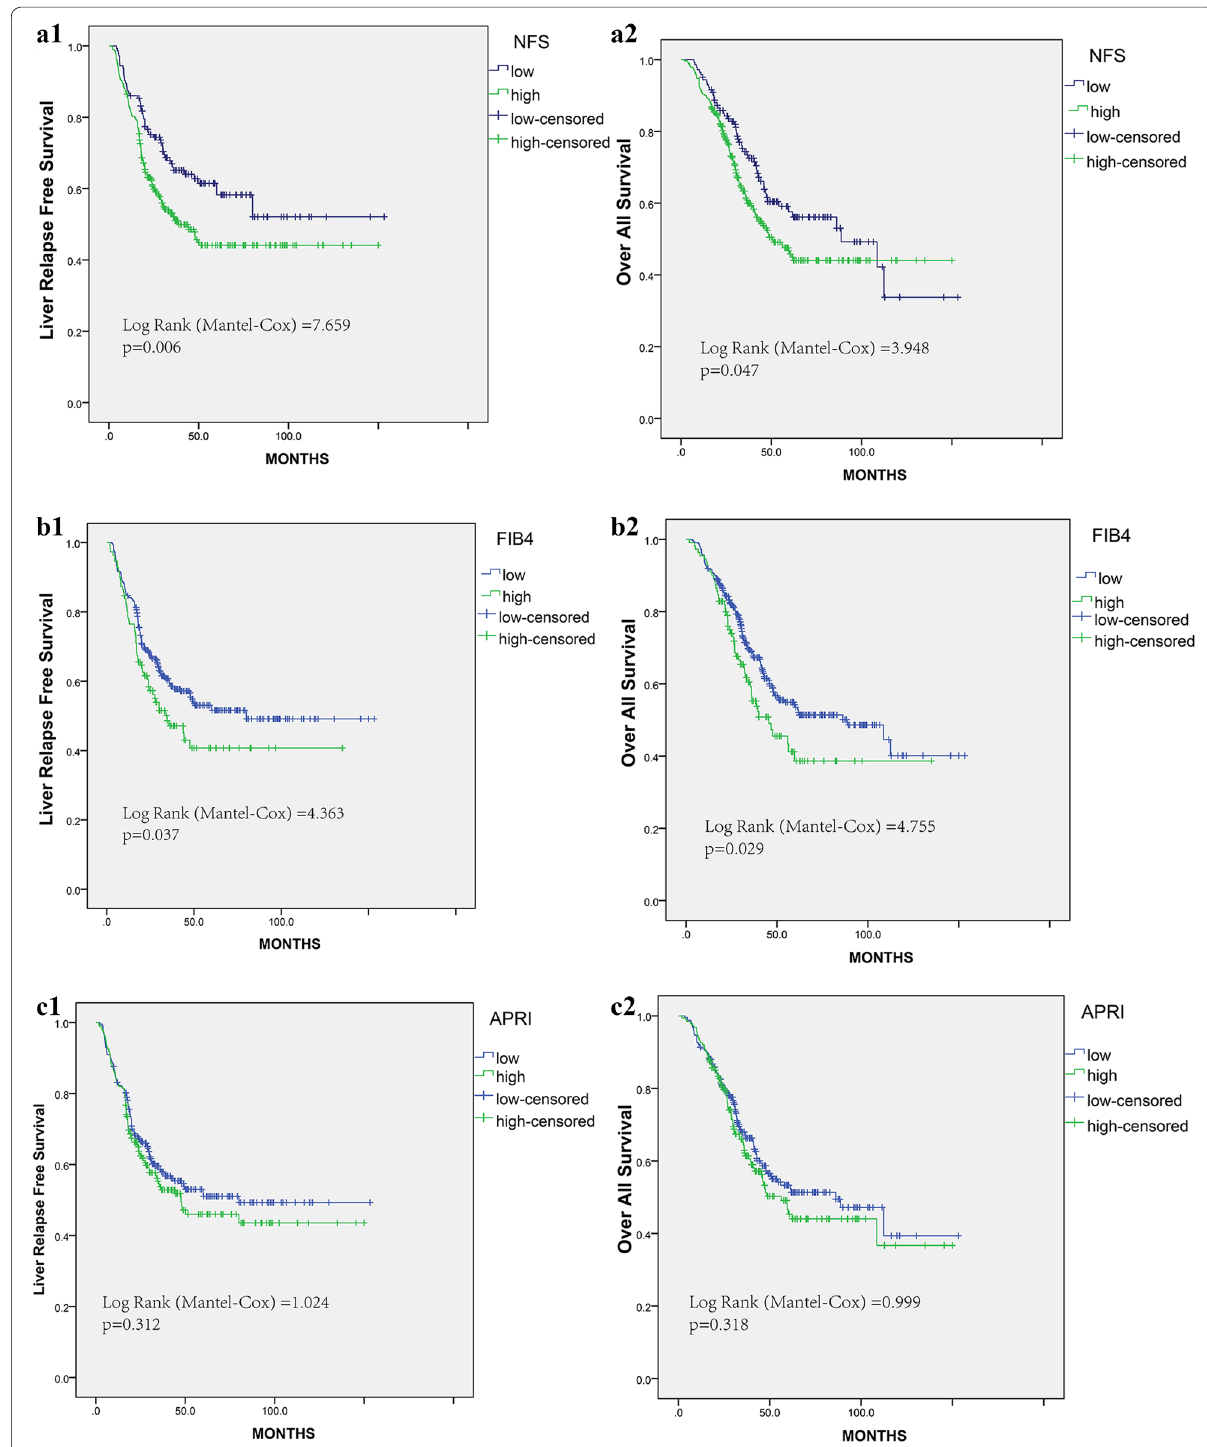
Fig. 4 Liver fibrosis score in NFS, FIB4, APRI measured by Kaplan–Meier survival for liver RFS and OS in the validation cohort. a1 NFS for liver RFS, a2 NFS for OS. b1 FIB4 for liver RFS, b2 FIB4 for OS. c1 APRI for liver RFS, c2 APRI for